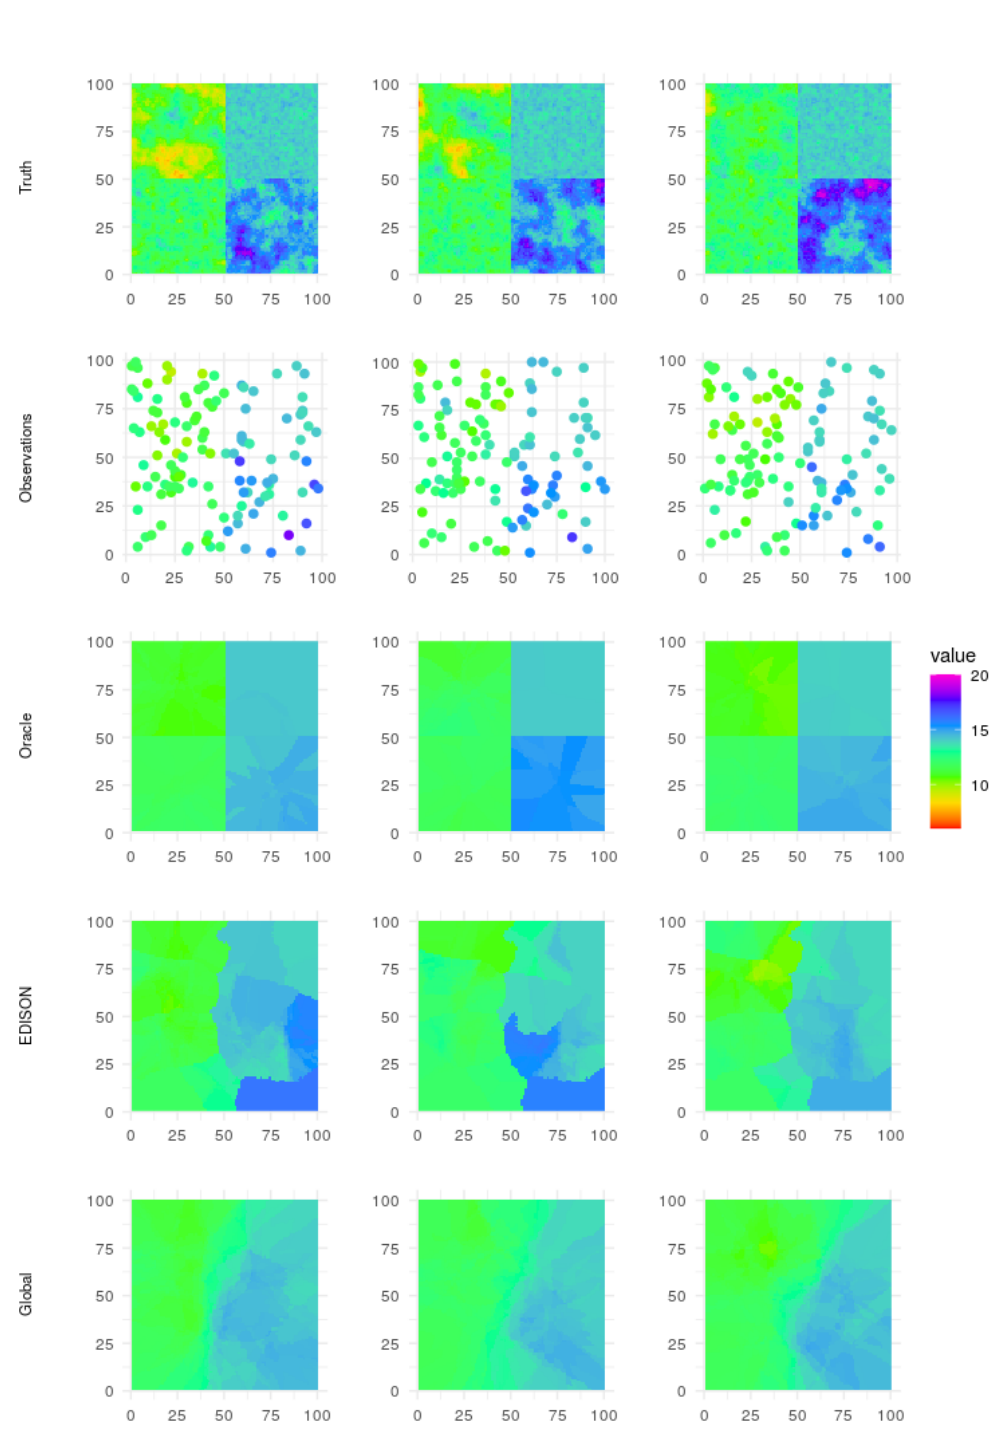
Figure 7. Ground truth, observations, and interpolations. The interpolations are conducted with oracle clustering, EDISON clustering, as well as a global variogram with no clustering. First three time frames of test data set are shown, from left to